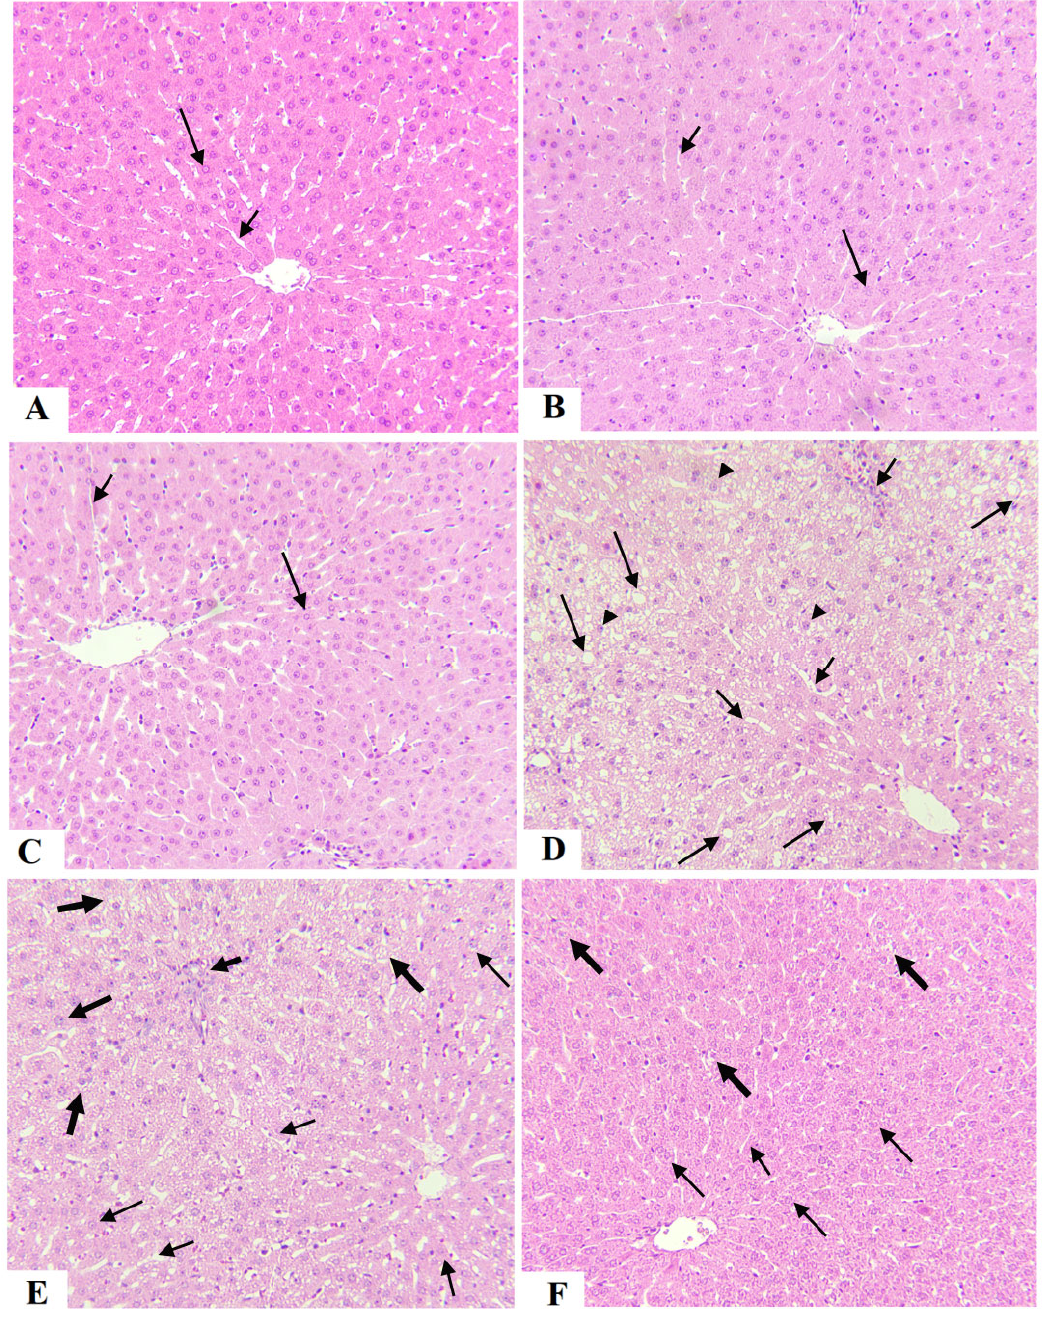
Figure 5. Photomicrographs of the livers of all groups of rats. H&E (200 × ). ( A – C ) Control, control + oggtt (2 mL), and control + Oggtt (5 mL) showing normal hepatocytes (long arrow), central vein (CV), and sinusoids (short arrow). ( D ) HFD-fed rats show increased cytoplasmic fat vacuolization in the hepatocytes (long thin arrow), dilated sinusoids (short thin arrow), immune cell infiltration (short thick arrow), and pyknotic necrotic cells (arrowheads). ( E ) HFD + oggtt (2 mL) rats show an improvement in the structure of the liver of cells with an obvious increase in the number of normal cells (long arrow), a reduction in the number and size of the fat vacuolated cells (long thick arrow), and reduced size of sinusoids (short arrow). Few immune cells are still seen (short thick arrow). ( F ) HFD + oggtt (5 mL) rats show the maximum improvement in the liver structure, with most of the hepatocytes being normal (long thin arrow), and sinusoids (short arrow). However, fewer cells still showed fat accumulation but with smaller sizes (long thick